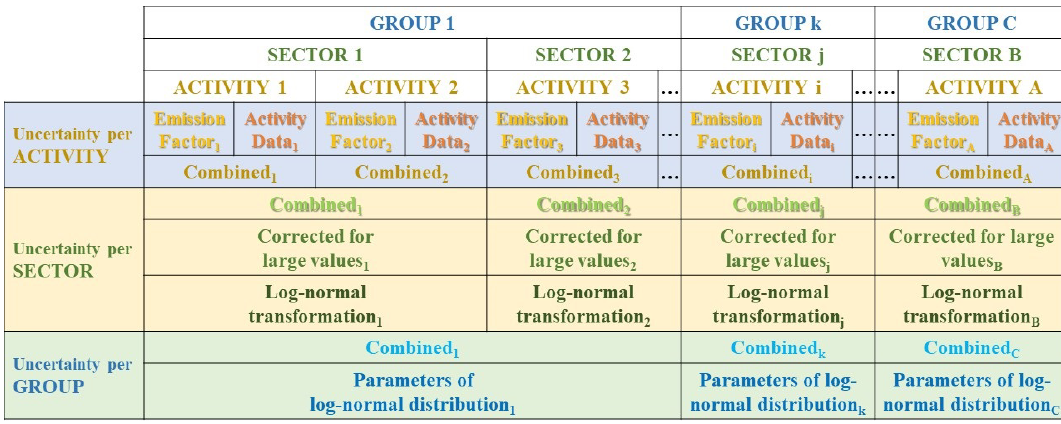
Figure 1. Yearly uncertainty calculation simplified